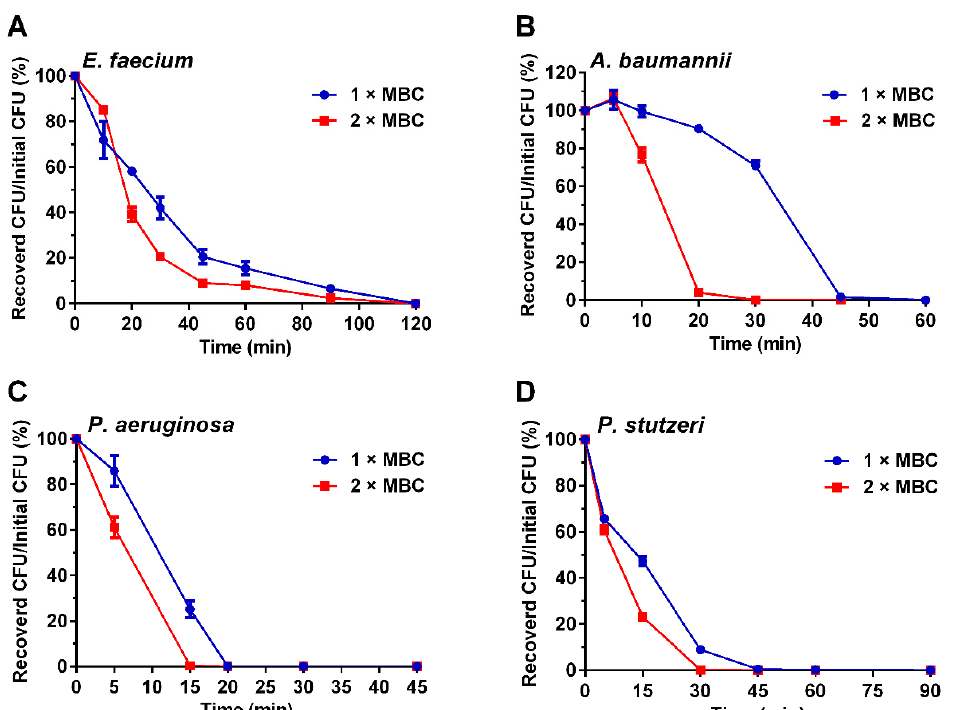
Figure 2. The bactericidal kinetics of Sp-LECin against E. faecium ( A ), A. baumannii ( B ), P. aeruginosa ( C ) and P. stutzeri ( D ) at 1 × , and 2 × MBC. Data represent mean ± standard error of mean from three independent biological replicates.